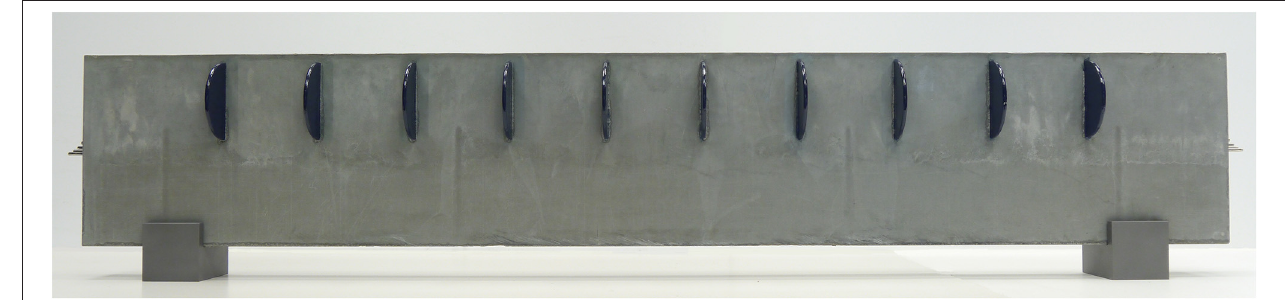
Frontiers in Built Environment |